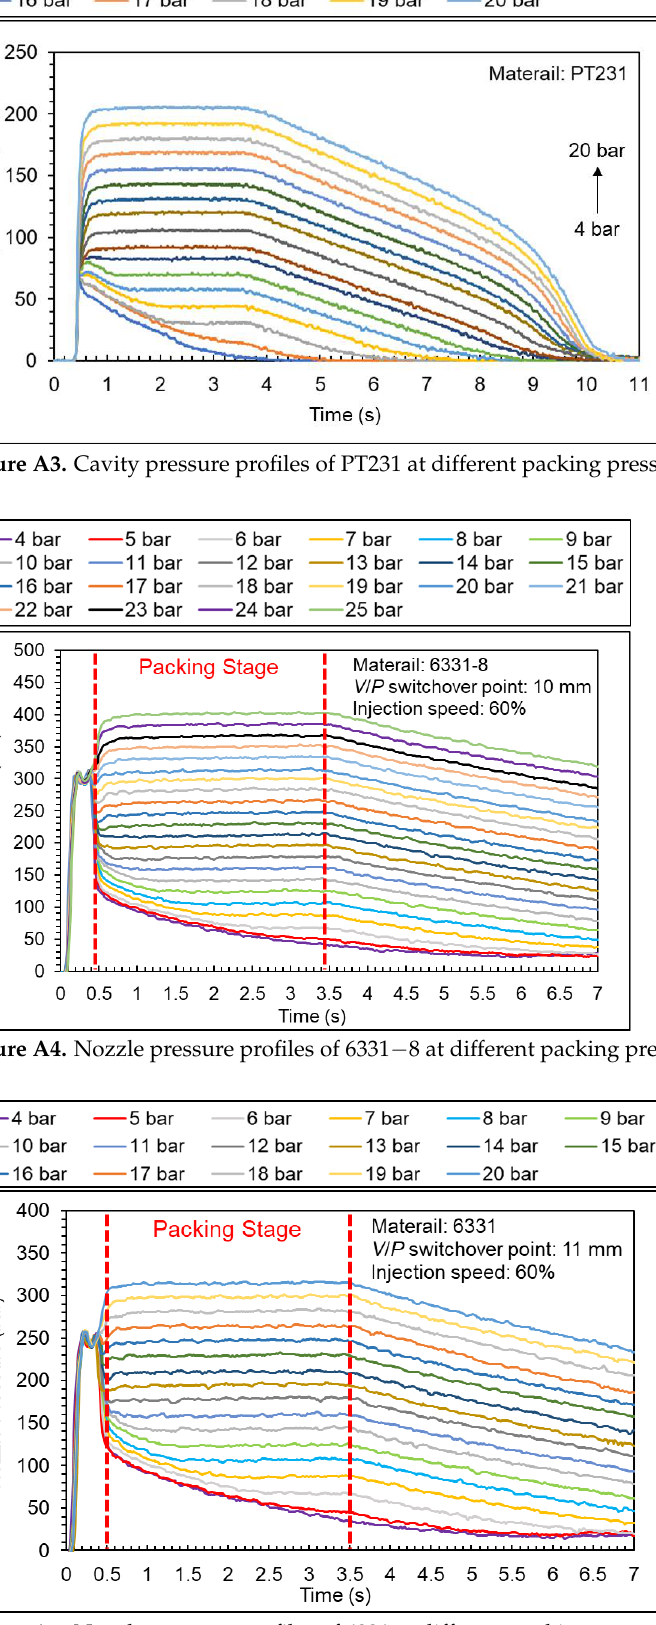
Figure A5. Nozzle pressure profiles of 6331 at different packing